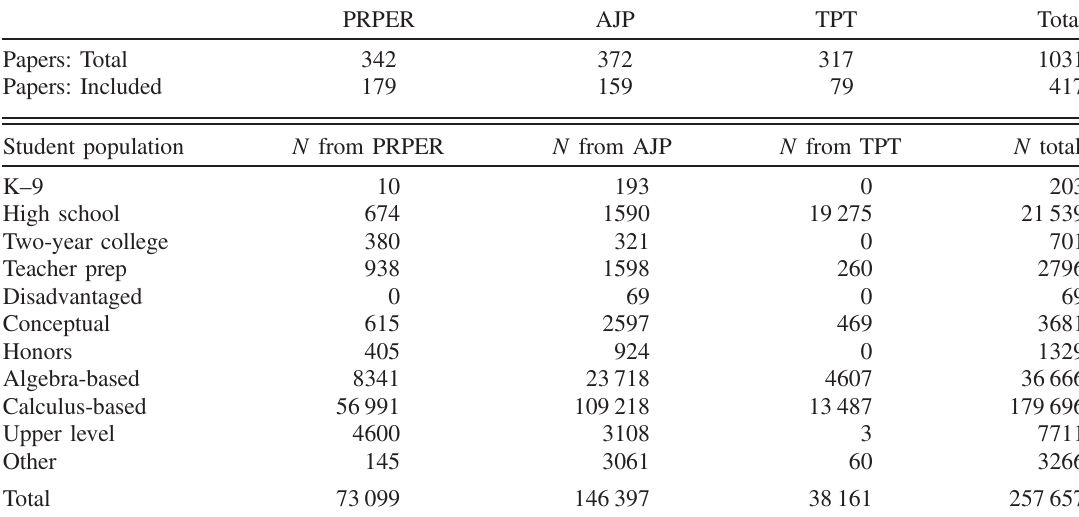
TABLE I. Number of papers included in this study and number of total students in various populations of courses from included papers.